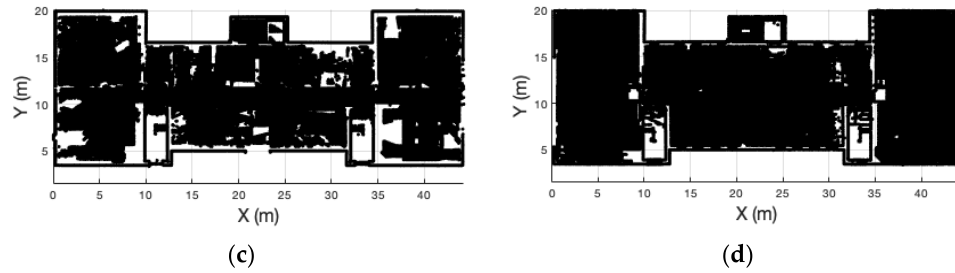
Figure 13. Results for storey separation of Old Sun; ( a ) Fourth storey floor; ( b ) Fourth storey ceiling; ( c ) Third storey floor; ( d ) Third storey ceiling.